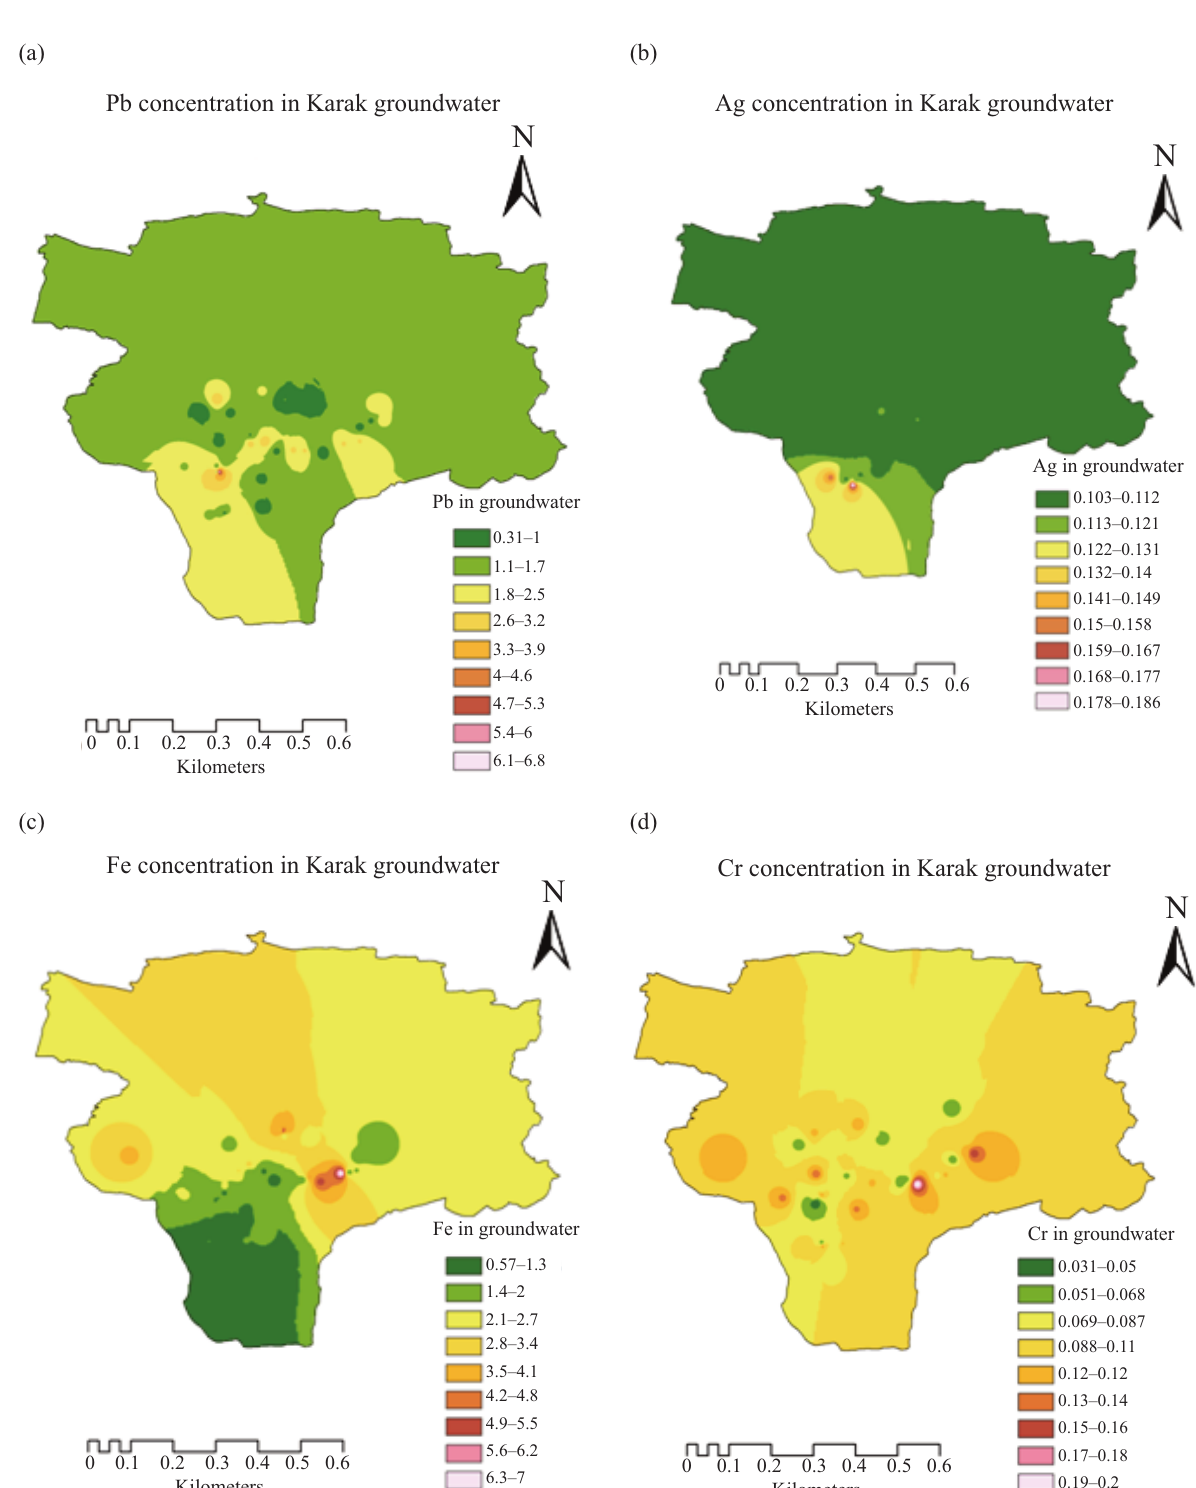
Fig. 2. Concentration of heavy metals (HMs) in mg/L in different groundwater samples: (a) – Pb(II), (b) – Ag(I), (c) – Fe(II), (d) – Cr(VI)